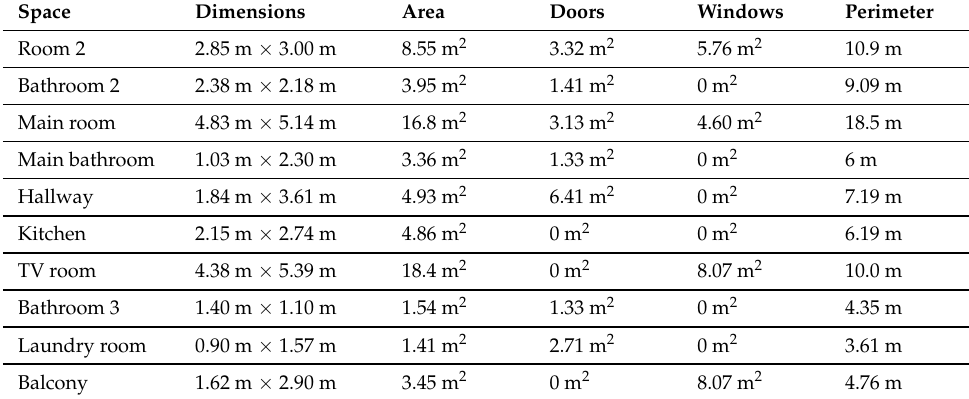
Table 3. Dimensions and characteristics of the controlled space.